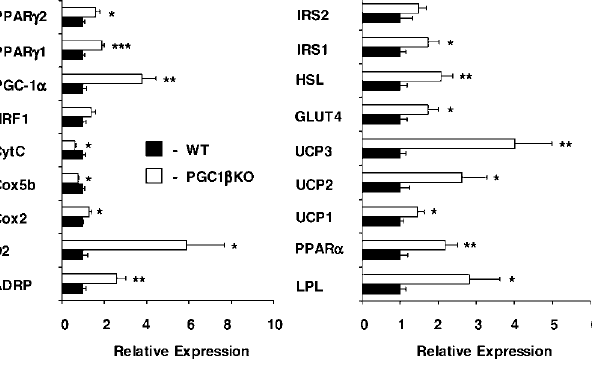
Figure 3. PGC-1 b Ablation Results in Major Changes in BAT Metabolic Gene Expression Expression levels of mRNA were assessed on interscapular BAT from 12- wk-old male WT (black bars) and PGC1 b KO (white bars) mice. Individual measurements are standardized using 18S, and the average of the WT group set to 1. n ¼ 5–7 mice per group. DOI: